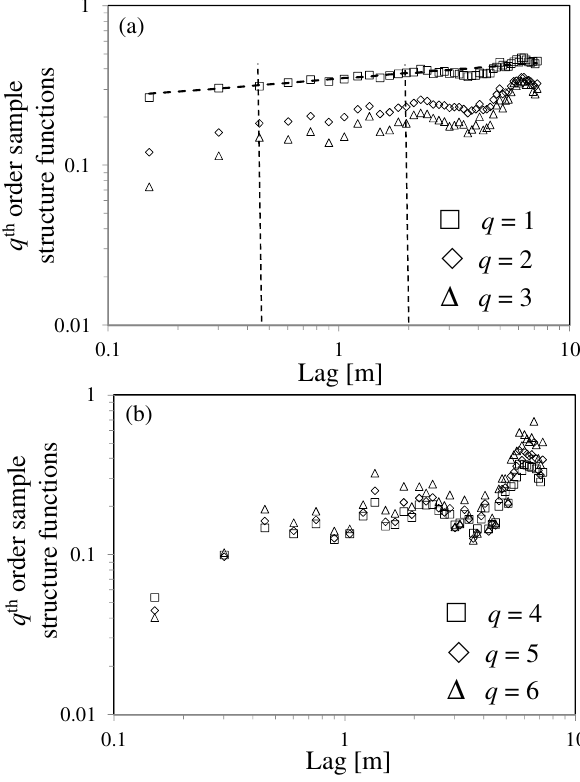
Fig. 13. Sample structure functions of order q =1, 2, 3, 4, 5, 6 of Utah data from transects D and H (bioturbated sandstone). Light vertical broken lines demarcate mid-range of lags within which heavy inclined broken line, with slope taken to represent ξ ( 1 ) , was fitted to S 1 N